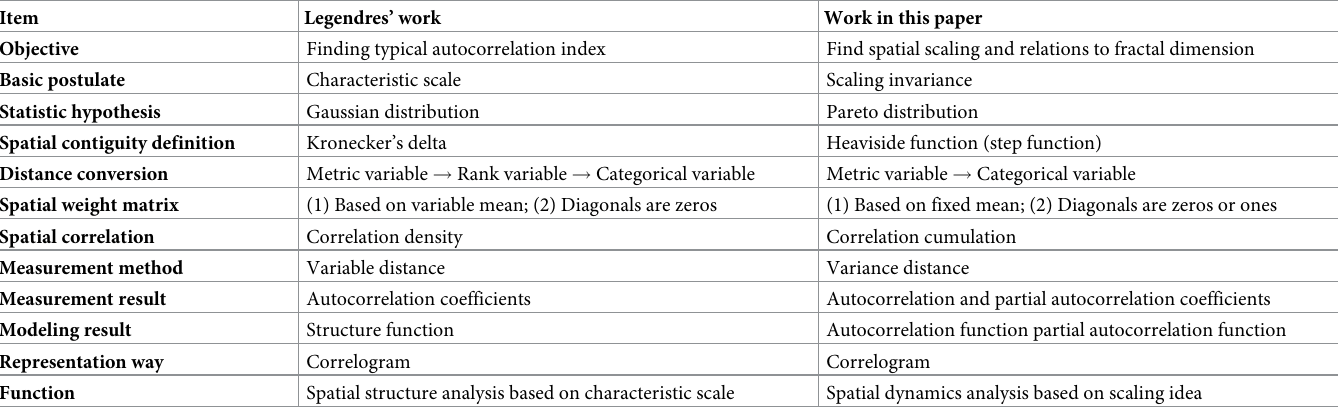
Table 4. The differences and similarities between structure function and spatial autocorrelation function.